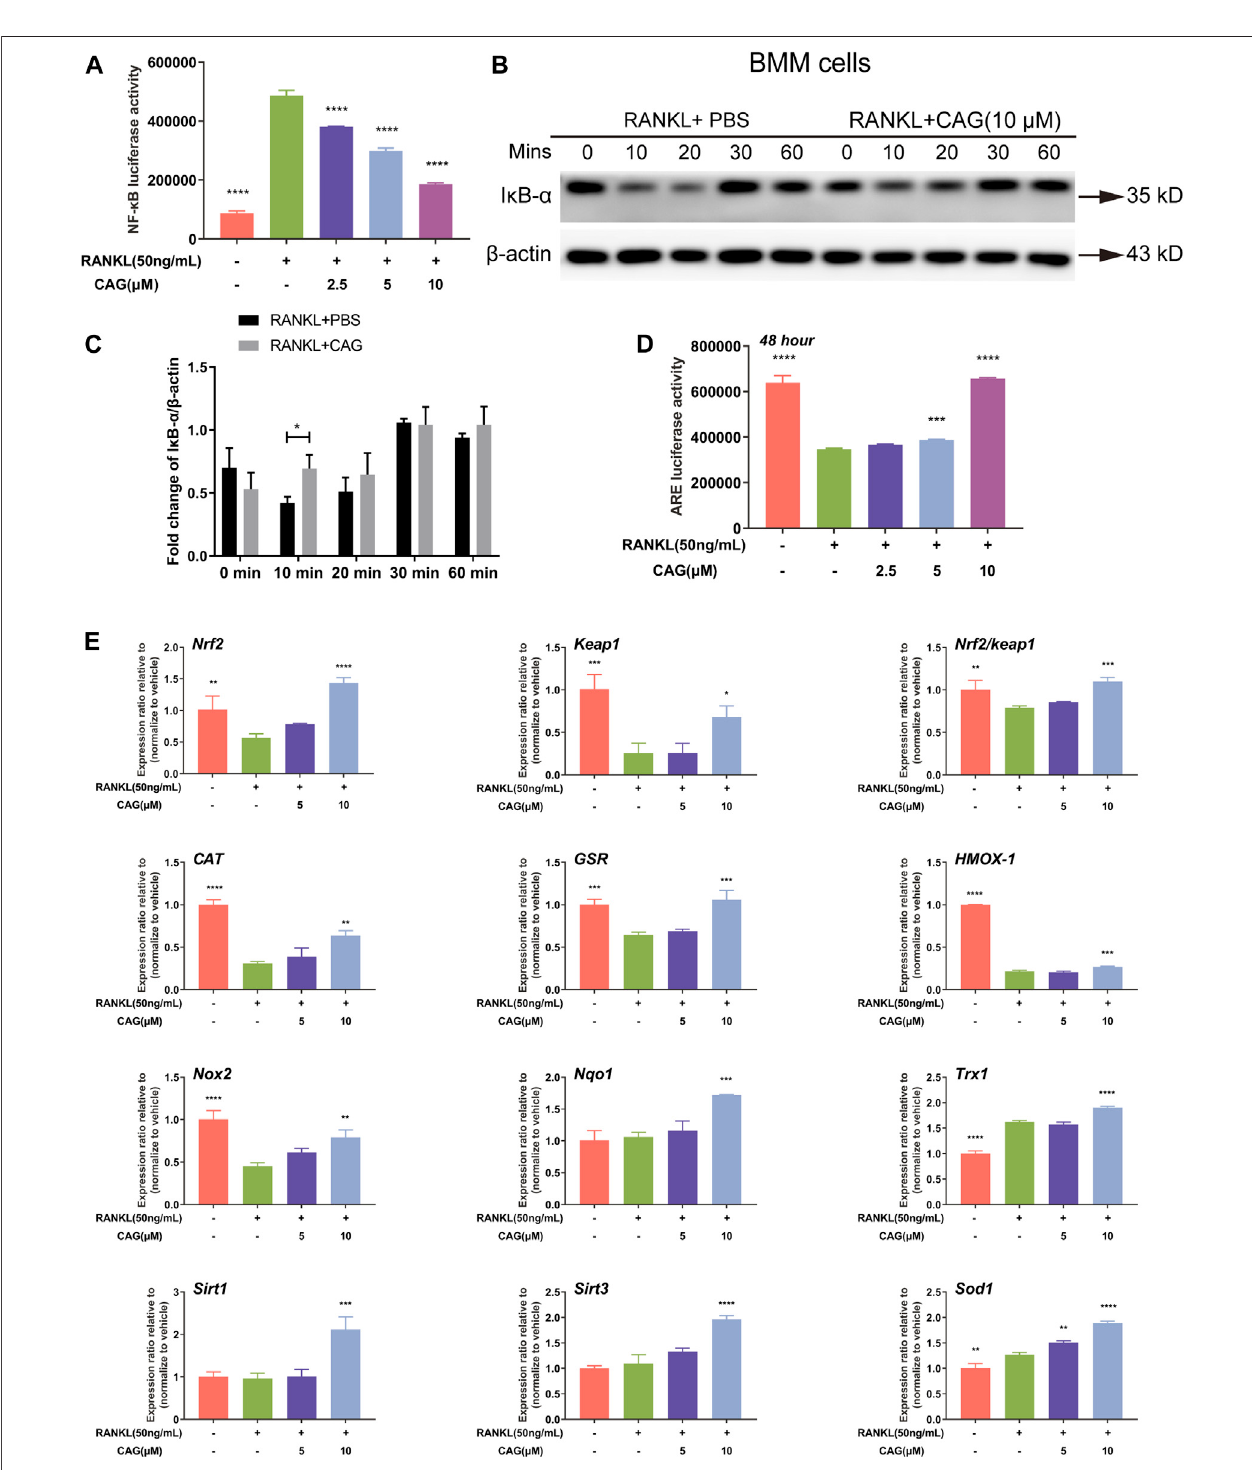
FIGURE 3 | CAG inhibits the NF- κ B pathway and promotes Nrf2/Keap1/ARE pathway. (A) Luciferase reporter gene assay in RAW264.7 cells presented that the activity of NF- κ B triggered by RANKL decreased after treated with 2.5, 5, and 10 µM CAG. (B) Typical western blot images of protein expression in BMMs treated with 10 µMCAGfor10,20,30,and60 min. (C) QuantitationrevealedthattherelativeexpressionofI κ B- α proteinsigni fi cantlyincreasedafterBMMsweretreatedwithCAGat 10 min. (D) Luciferase reporter gene assay in RAW264.7 cells proved that CAG administration dose-dependently increased the activity of ARE suppressed by RANKL. (E) Real-timeqPCRassaydemonstratedthatCAGtreatmentof5and10 µMledtheexpressionofgenesintheNrf2/Keap1pathwayandtheNrf2/Keap1ratioto rise dose-dependently. Data of all histograms are displayed as mean (SD). n (cid:1) 3. * p < 0.05, ** p < 0.01, *** p < 0.001. **** p < 0.0001. NF- κ B: nuclear factor- κ B;